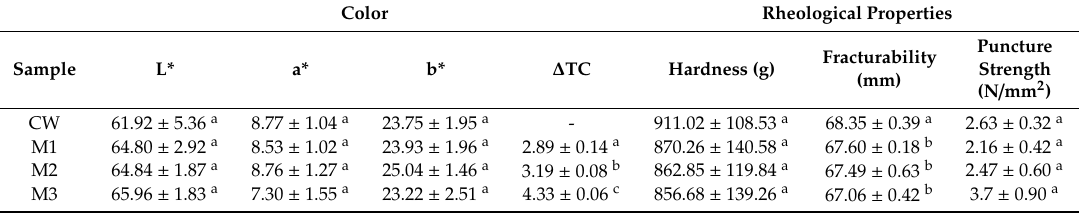
Table 1. Characteristic of the content of bioactive compounds and functional properties of wafers.